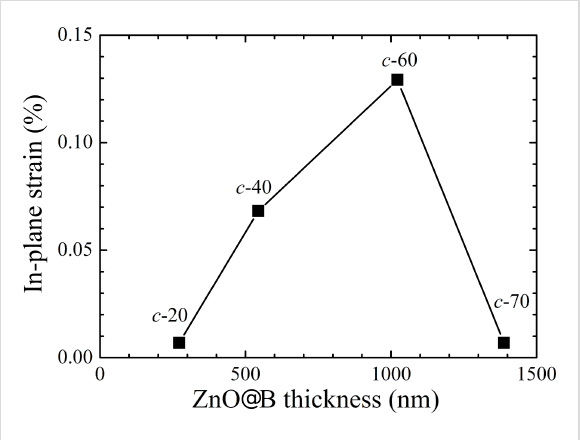
Figure 7: In-plane strain for the four ZnO@B samples as a function of ZnO